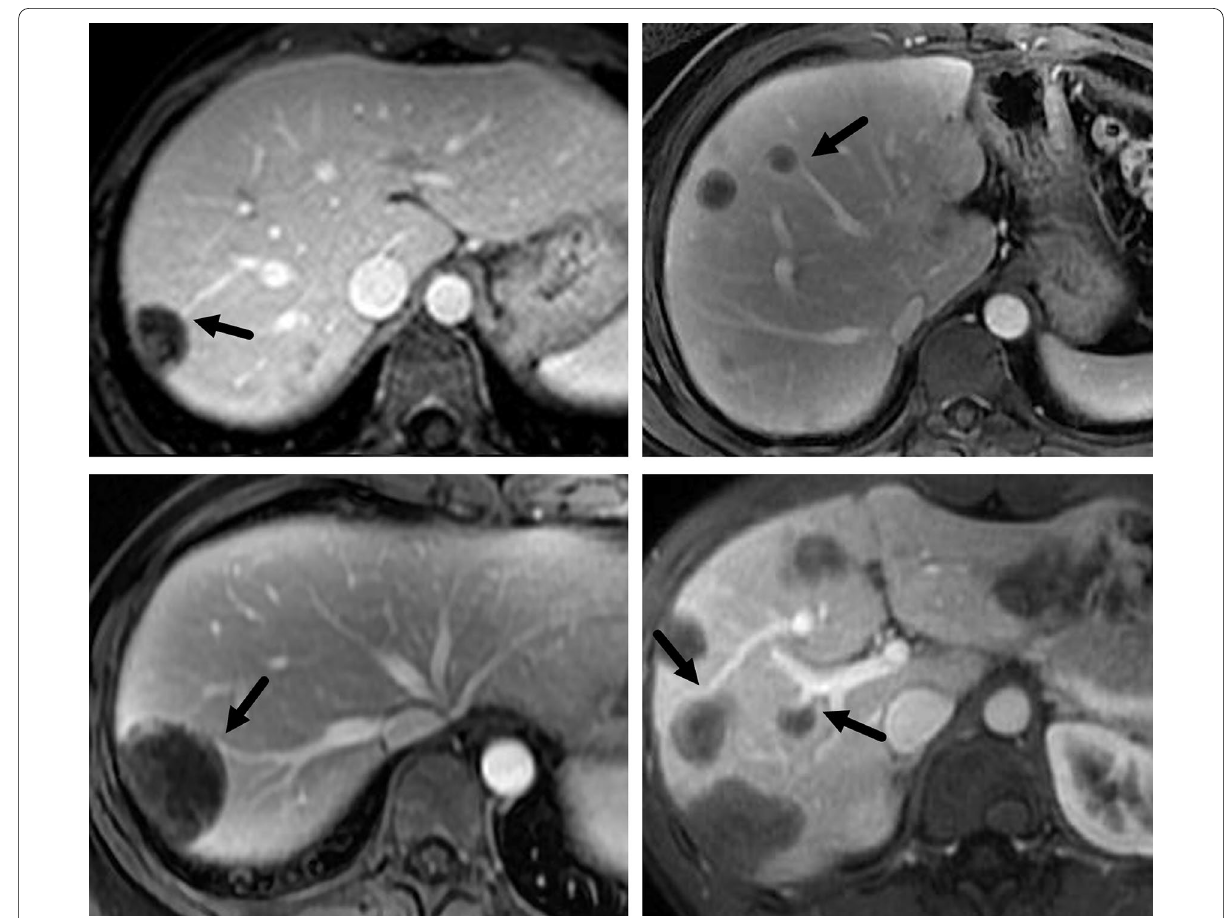
Fig. 7 The appearance of lollipop sign on MRI images of 4 HEH patients